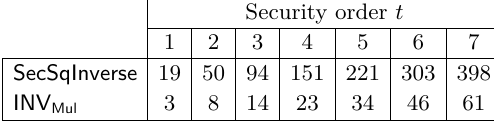
Table 4: Randomness usage comparison for the inversion in S/q between multiplicative masking and our technique, in thousands of calls to the RNG outputting 32 bits of